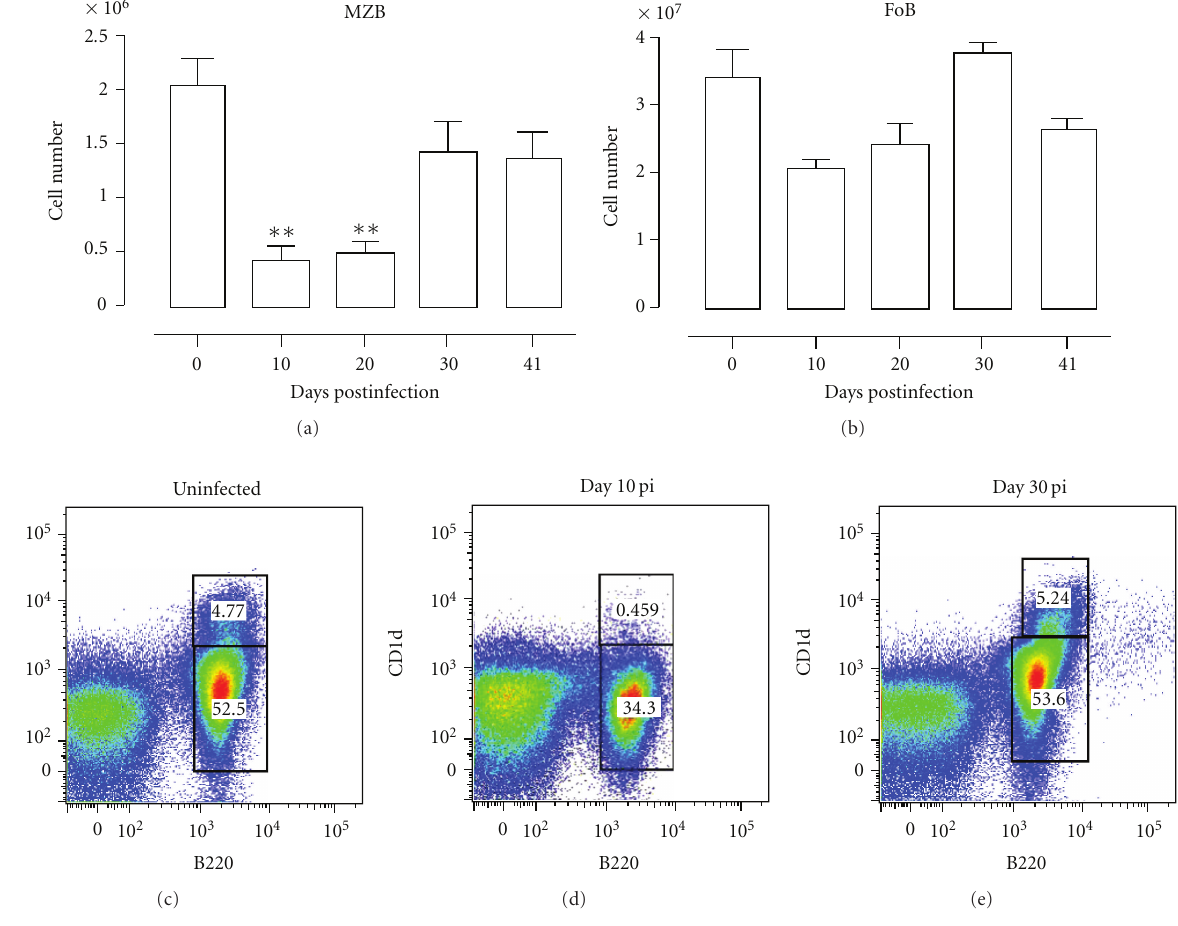
Figure 7: Depletion of MZB but not FoB cells in spleen during Pc AS infection. (a) and (b) Spleens cells from noninfected mice and mice infected with Pc AS for 10–41 days were stained for surface markers commonly used to define MZB (a) and FoB (b) cells and analyzed using FACS. Data are represented as mean of three mice per group ± SEM, two independent repeat experiments were performed and statistics are compared to uninfected controls ( ∗∗ ) P < . 01. (c), (d), and (e) MZB and FoB cells were detected as (AA4.1 − ) B220 + CD1d + (CD23 lo CD21 hi